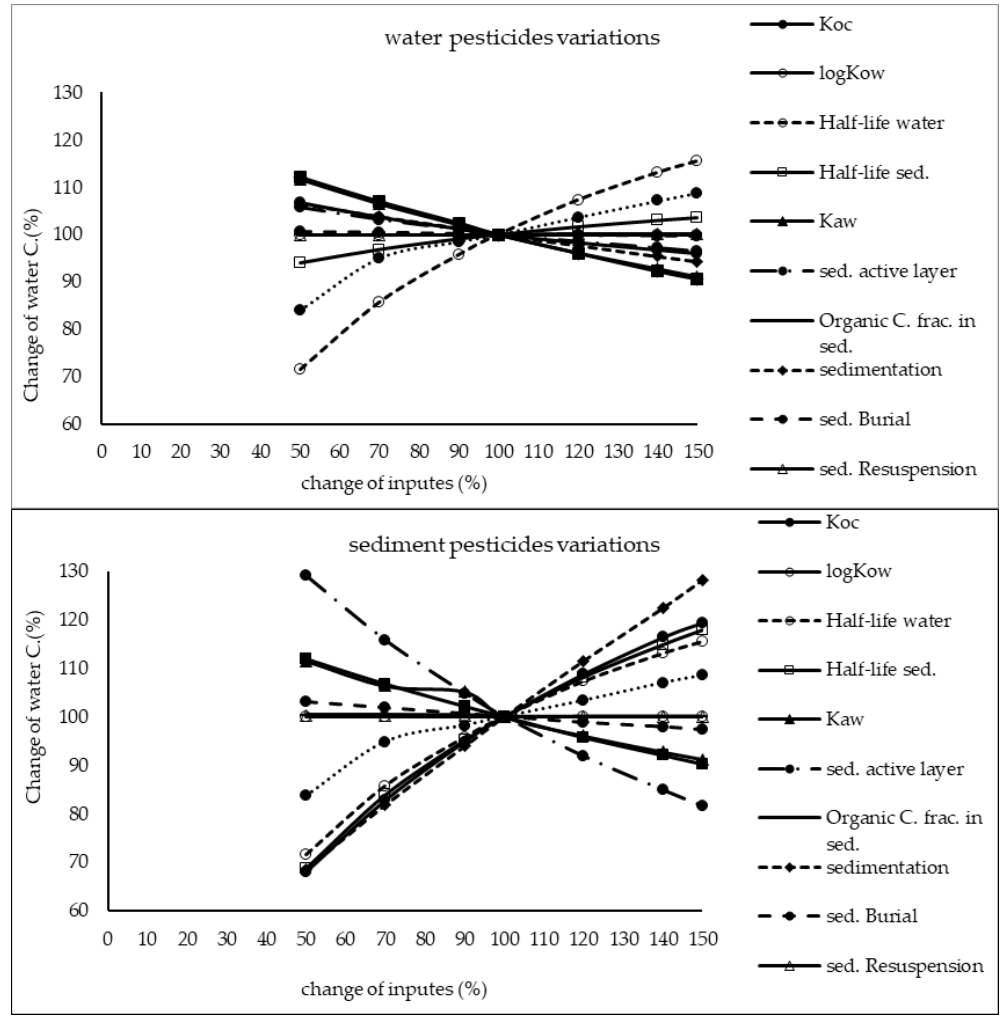
Figure 3. Results of the sensitivity analysis for methoxychlor in Lake Naivasha.